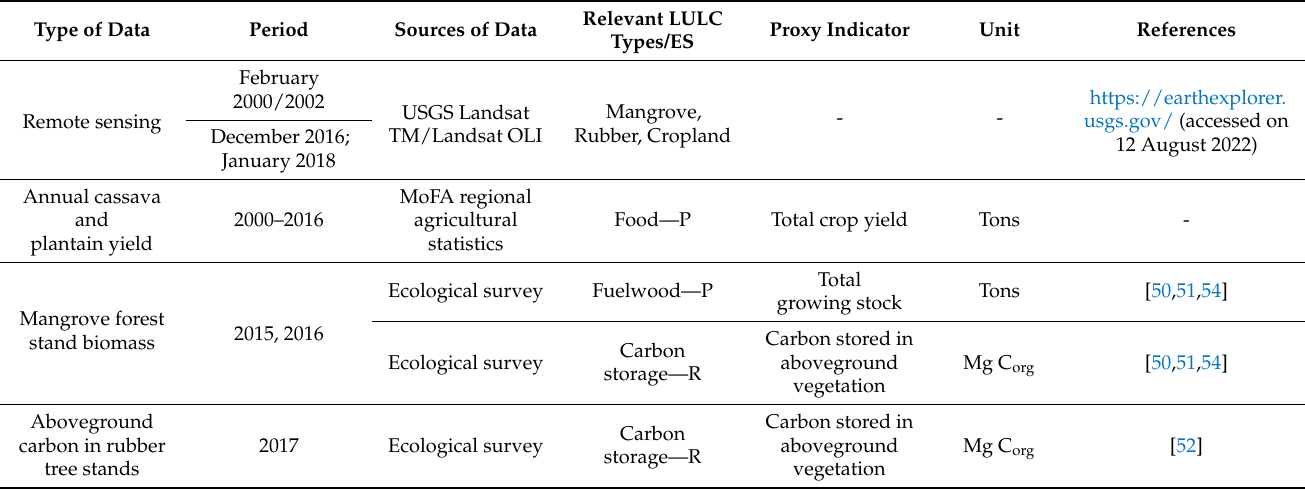
Table 1. Types and sources of data utilized for assessing ES in the coastal landscapes of Southwestern Ghana. LULC = land use/land cover types; USGS = United States Geological Survey; TM = Thematic Mapper; OLI = Operational Land Imager; MoFA = Ministry of Food and Agriculture; ES = ecosystem services; P = provisioning services; R = regulating services; Mg C org = quantities of organic carbon stored in vegetation; - = not